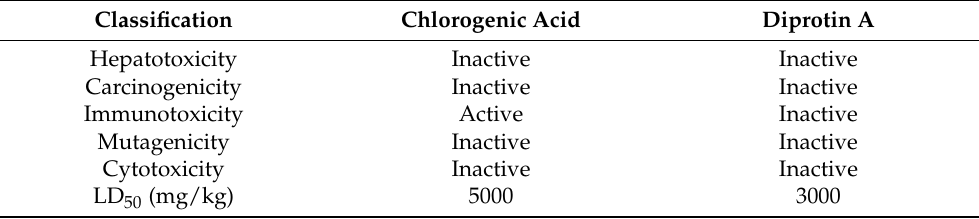
Table 4. Toxicity classifications and LD 50 of chlorogenic acid and Diprotin A. Classification Chlorogenic Acid Diprotin A Hepatotoxicity Inactive Inactive Carcinogenicity Inactive Inactive Immunotoxicity Active Inactive Mutagenicity Inactive Inactive Cytotoxicity Inactive Inactive LD 50 (mg/kg) 5000